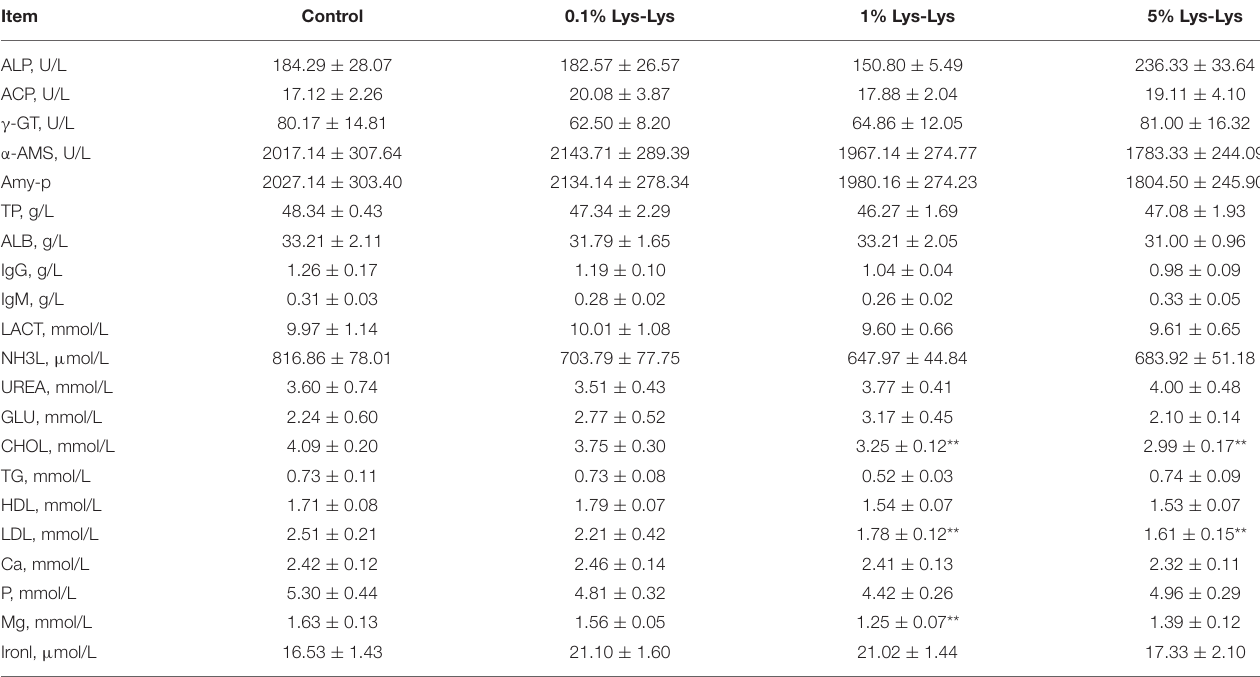
TABLE 2 | Effect of Lys-Lys on blood biochemical parameters of piglets a .